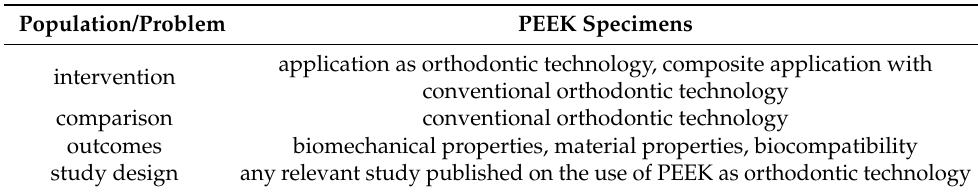
Table 1. Specification of the PICOS